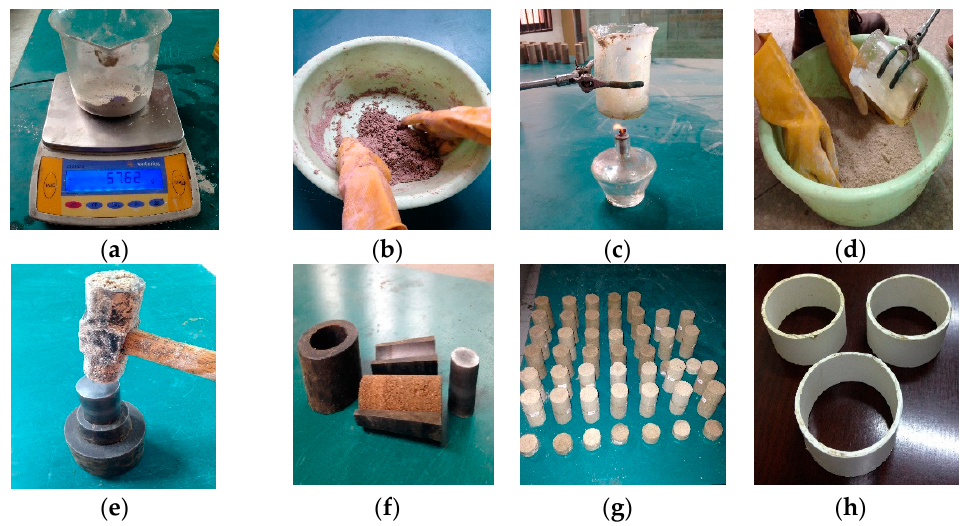
Figure 2. The fabrication process of similar-material specimen: ( a ) Weighing; ( b ) Stirring; ( c ) Heating vaseline; ( d ) Adding hydraulic oil; ( e ) Compacting; ( f ) Demolding; ( g ) Partial specimen; ( h ) PVC